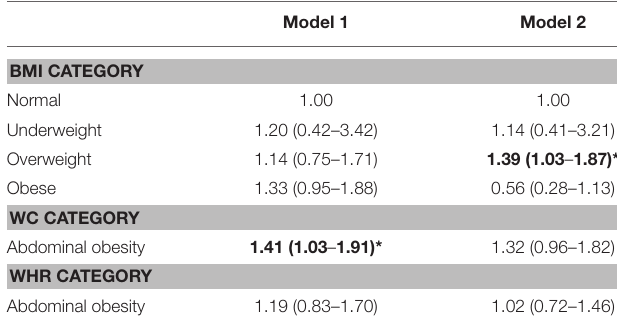
TABLE 2 | Risk factors associated with depression determined by multivariable logistic regression according to the Chinese criterion.